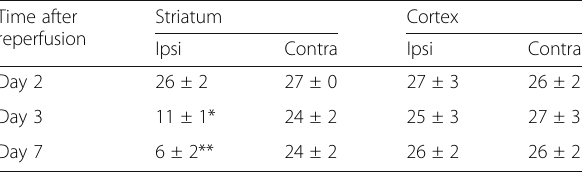
Table 2 Temporal changes in NeuN-positive cells in the striatum and cortex after mild focal ischemia